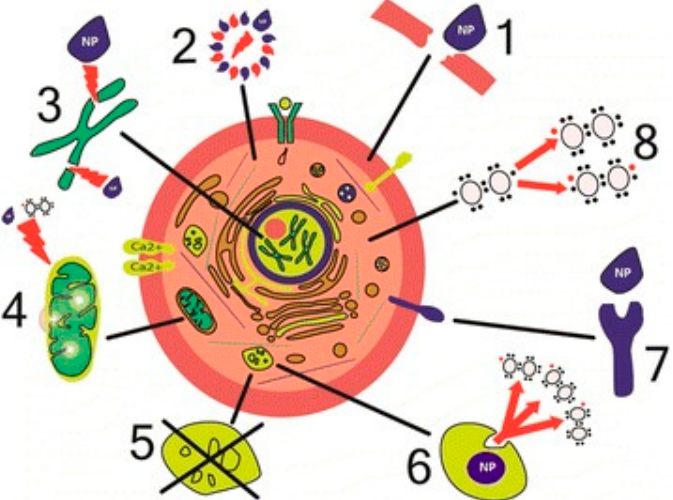
Figure 6. Mechanisms of cell damage by NPs. (1) Physical damage of membranes. (2) Structural changes in cytoskeleton components. (3) Disturbance of transcription and oxidative damage of DNA. (4) Damage of mitochondria. (5) Disturbance of lysosome functioning. (6) Generation of reactive oxygen species. (7) Disturbance of membrane protein functions. (8) Synthesis of inflammatory factors and mediators (Reproduced with permission from [189]).